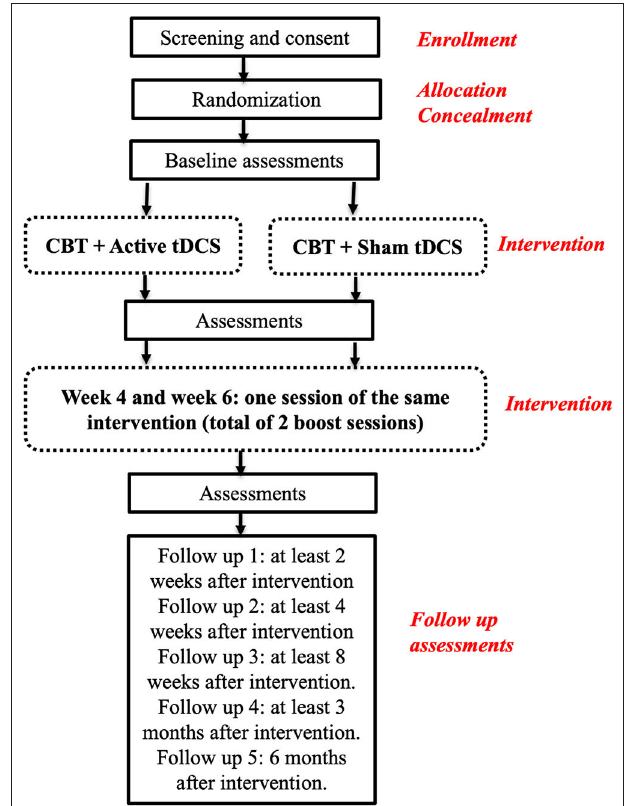
FIGURE 1 | Overview of the Study design (tDCS, transcranial Direct Current Stimulation; CBT, Cognitive Behavioral